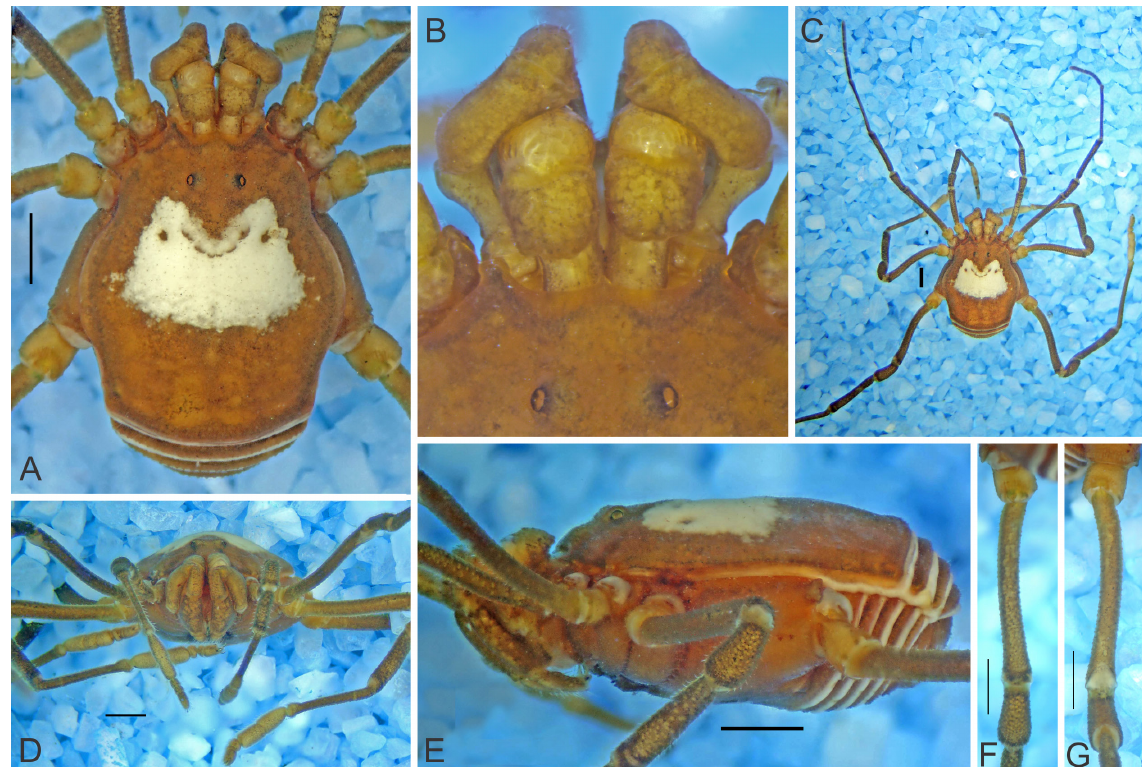
Fig. 9. Libitia gandalf sp. nov., holotype, ♂ (IAvH-I-69), habitus. A . Dorsal view. B . Dorsal view, anterior margin of carapace. C . Dorsal view, panoramic. D . Frontal view. E . Right lateral view. F–G . Right femur IV, dorsal and ventral view, respectively. Scale bars = 1